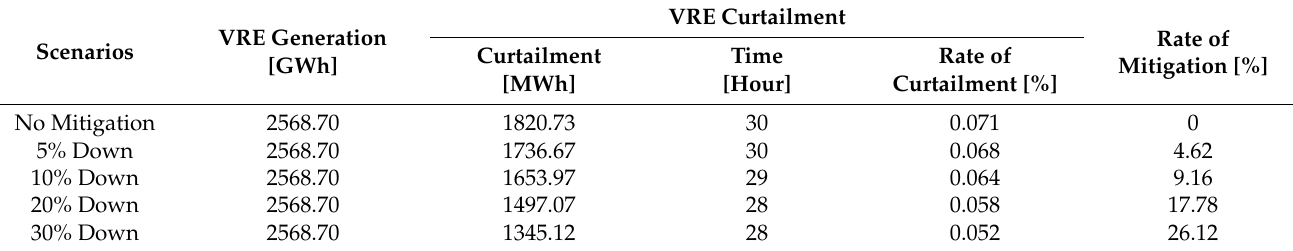
Table 12. Results of annual VRE curtailment by mitigation